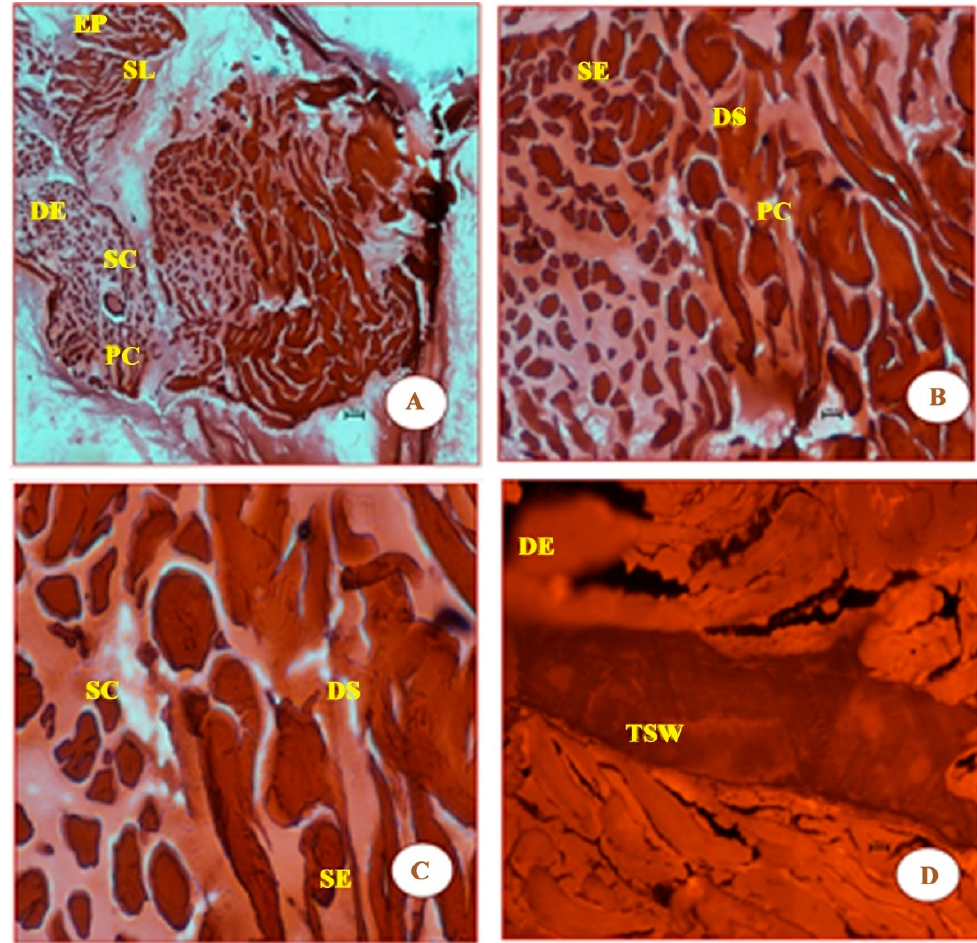
Figure 4. Panels ( A – D ) clearly show that there is more visible damage than shown in the four panels in Figure 3. In addition to epidermis (EP), stratum laxum (SL), stratum compactum (SC), and dermis epithelium (DE), which are found in Figures 2 and 3, Figure 4 also shows the following features: thickened septal wall (TSW), squamous epithelium (SE), squamous cells (SC), and pigment cells (PC). The latter four features were probably due to the strong energy of photons of UVB ( λ = 280 nm) radiation. Again, the cells in these panels appear to be both large and rough, compared with those from Figure 2. The magnification of the cells in the four panels are 4X, 10X, 20X, and 40X, respectively.